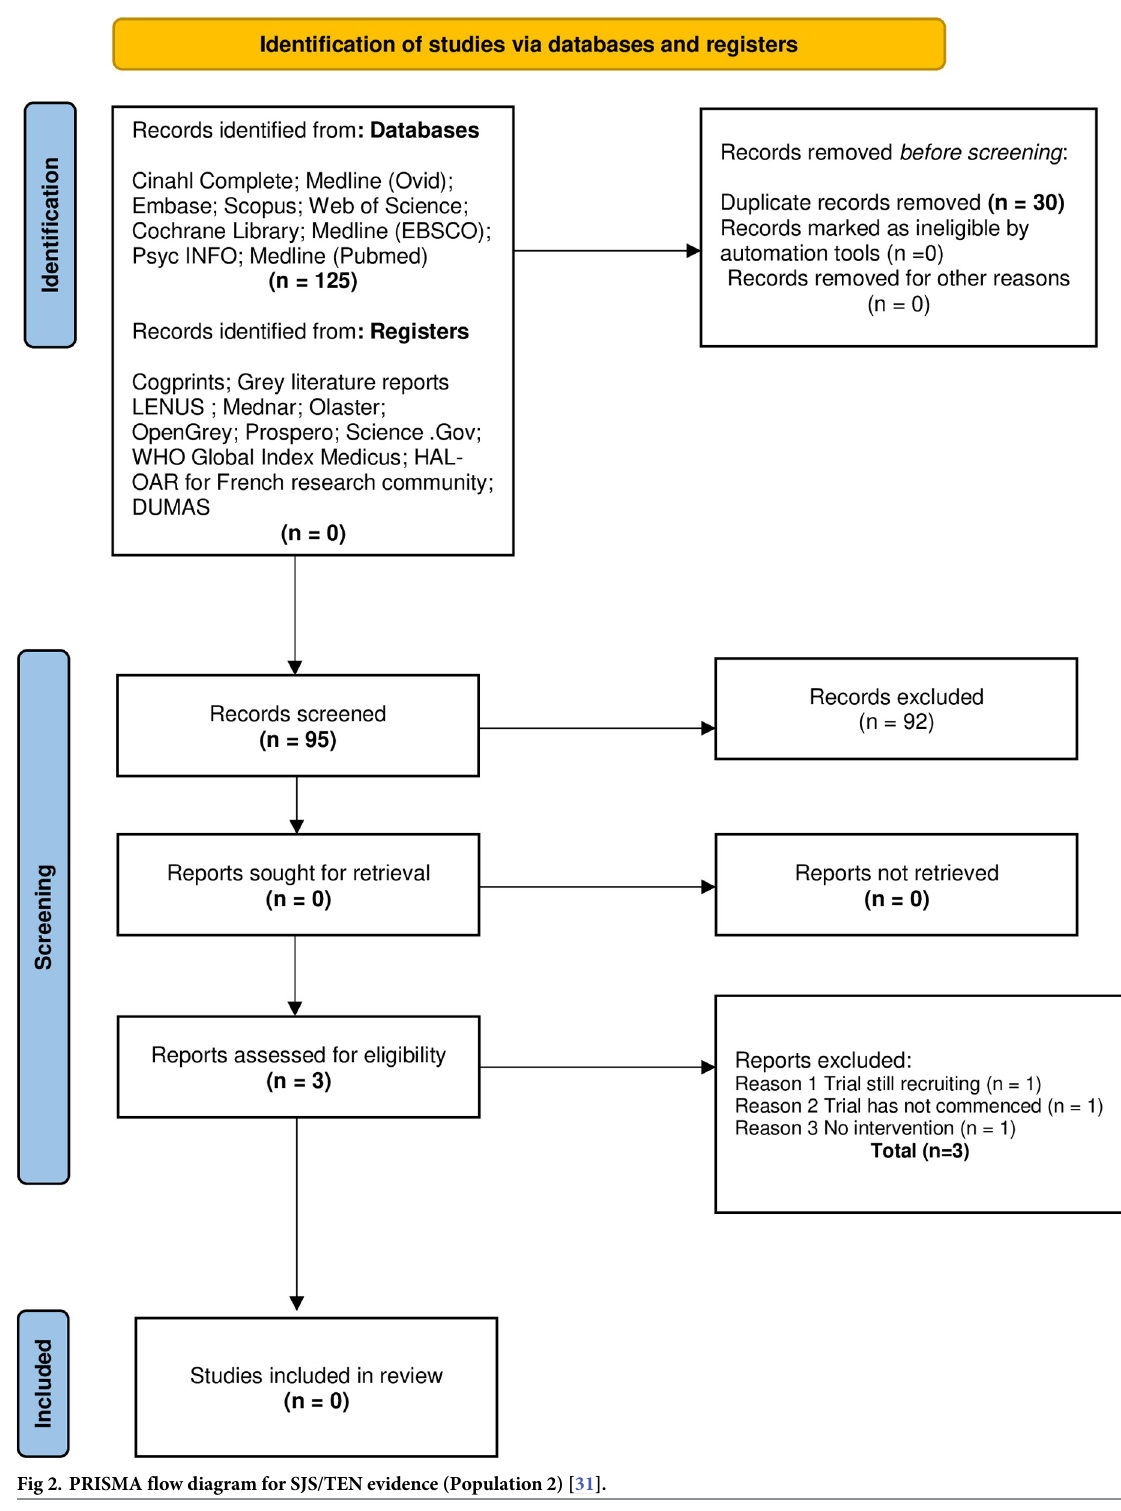
Fig 2. PRISMA flow diagram for SJS/TEN evidence (Population 2) [31].